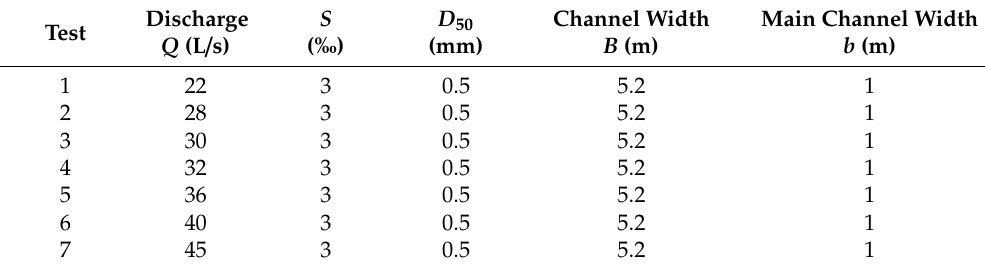
Table 1. Summary of the experimental